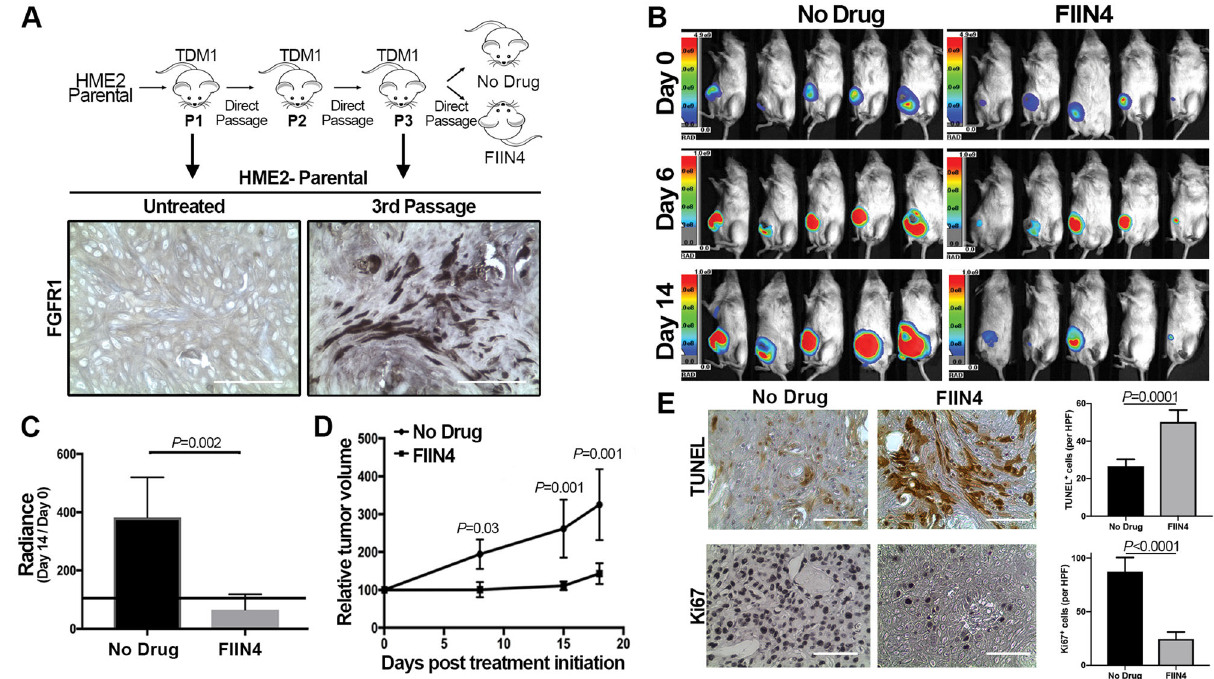
Fig. 6 T-DM1-resistant tumors respond to systemic inhibition of FGFR. A Schematic representation of the in vivo derivation of T-DM1- resistant HME2 tumors. HME2 parental cells (2 × 10 6 ) were engrafted onto the mammary fat pad of an NSG mouse. This mouse was treated